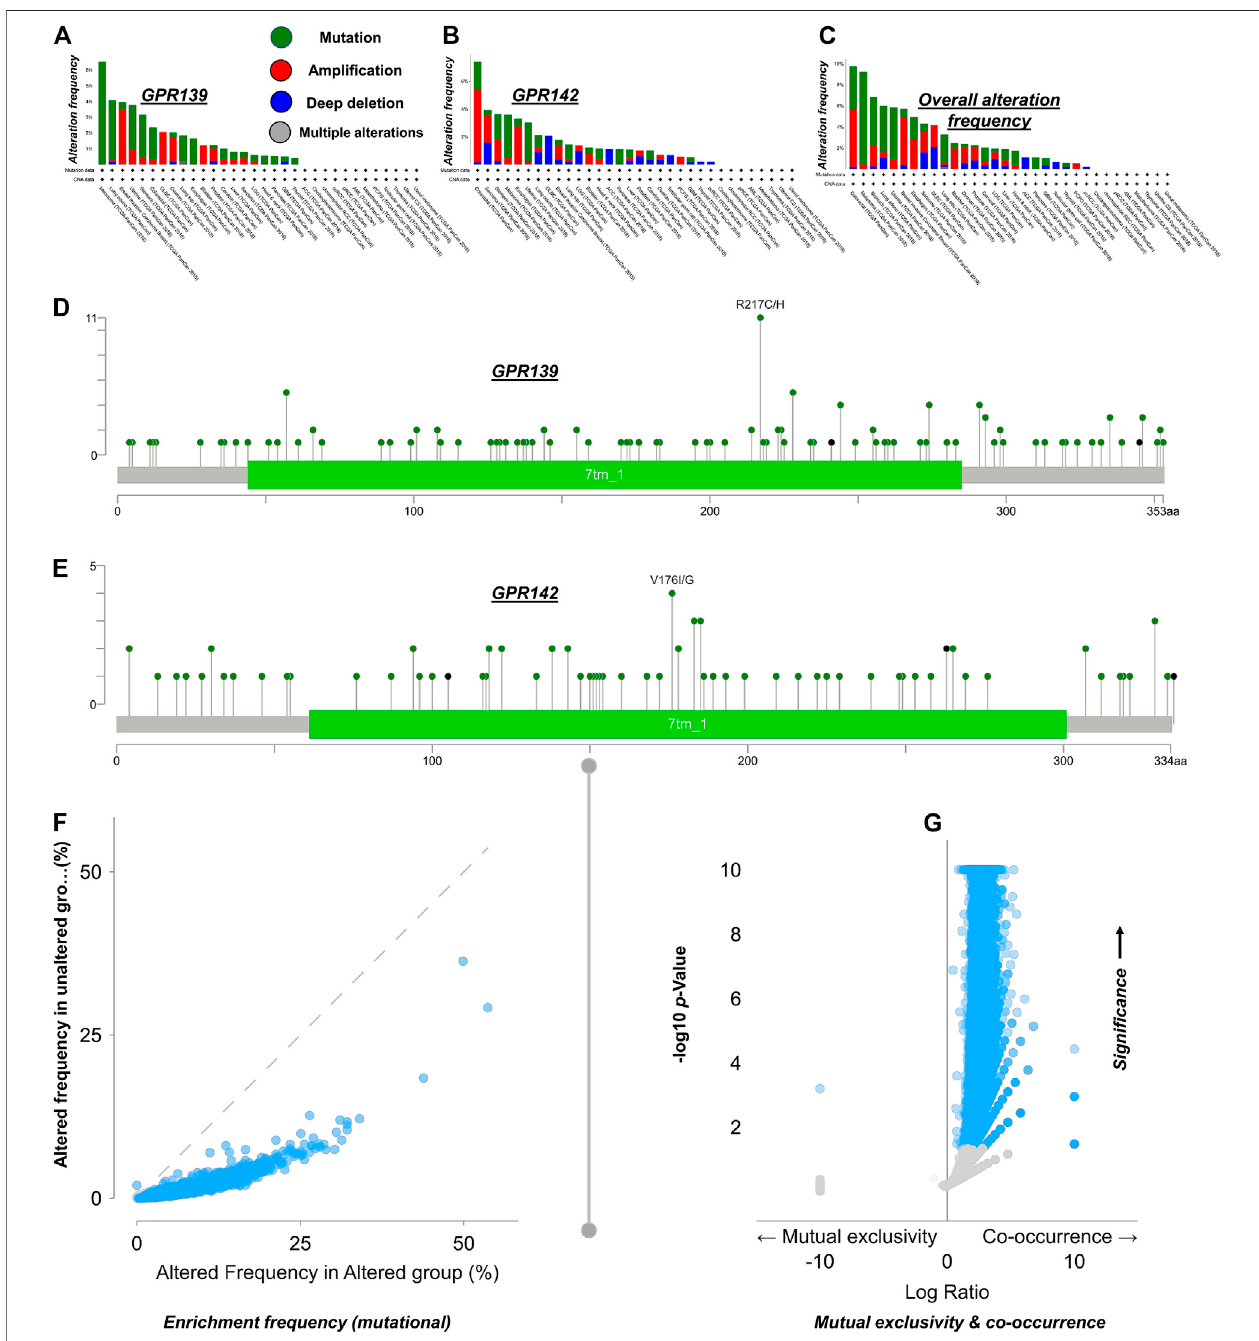
FIGURE 3 | GPR139 and GPR142 Global modi fi cation occurrence in pan-cancer based on the TCGA data Panel (A) GPR139 variation occurrence investigation; Panel (B) GPR142 variation frequency breakdown; Panel (C) Inclusive modi fi cation occurrence study; Panel (D) Ratio of the GPR139 mutations investigation; Panel (E) : Amount of GPR142 mutations breakdown. Panel (F) Amelioration rate, portraying genomic change per patient in the given samples, showing the mediation of GPR139 and GPR142 signaling in the pan-cancer. Besides, the gene signaling can be facilitated as well upon the instigation or inactivation of cell cycle control through truncating mutations. Panel (G) This board illustrates the amount of mutations uniqueness vs co-occurrence in the Genome.